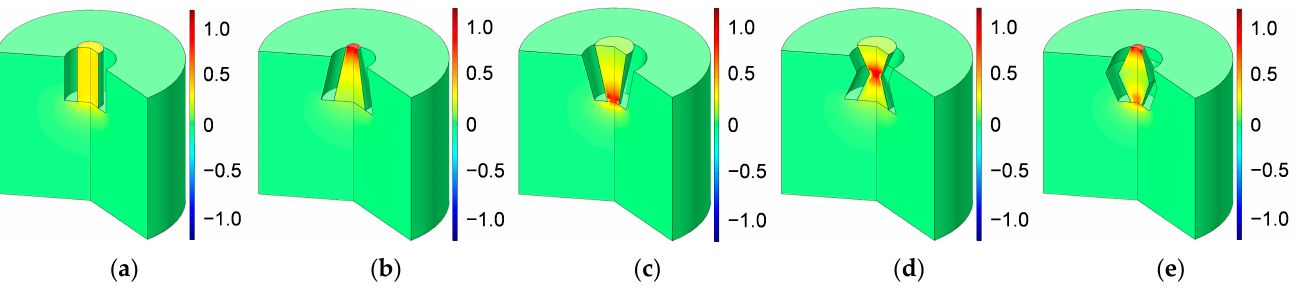
Figure 21. Distribution of acoustic velocity for the HR with aperture for various tangent sectional shapes. ( a ) Rectangle; ( b ) common trapeziform; ( c ) reverse trapeziform; ( d ) dumbbell; and ( e ) olive.